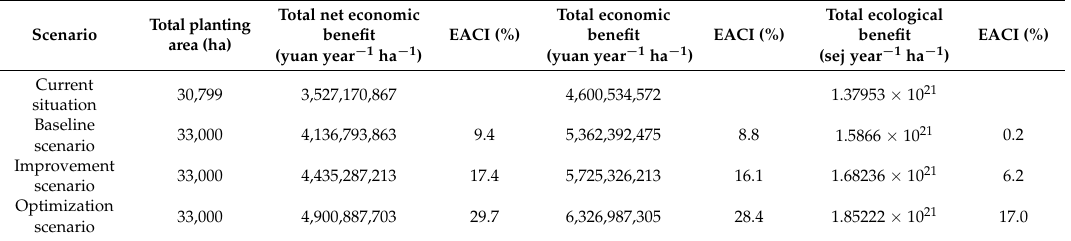
Table 6. Emergy and economic status after five years under each scenario